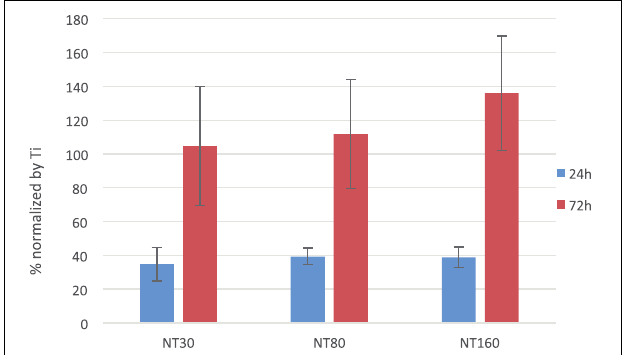
FIGURE 7 | Cell density after 24 and 72 h.